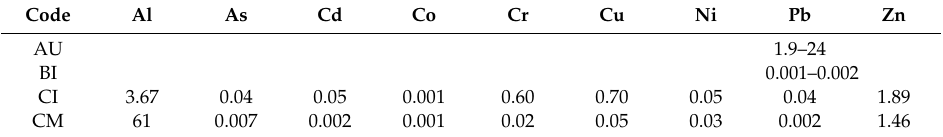
Table 6. Concentration of heavy metals and metalloids in the water (values expressed in mg / L). Code